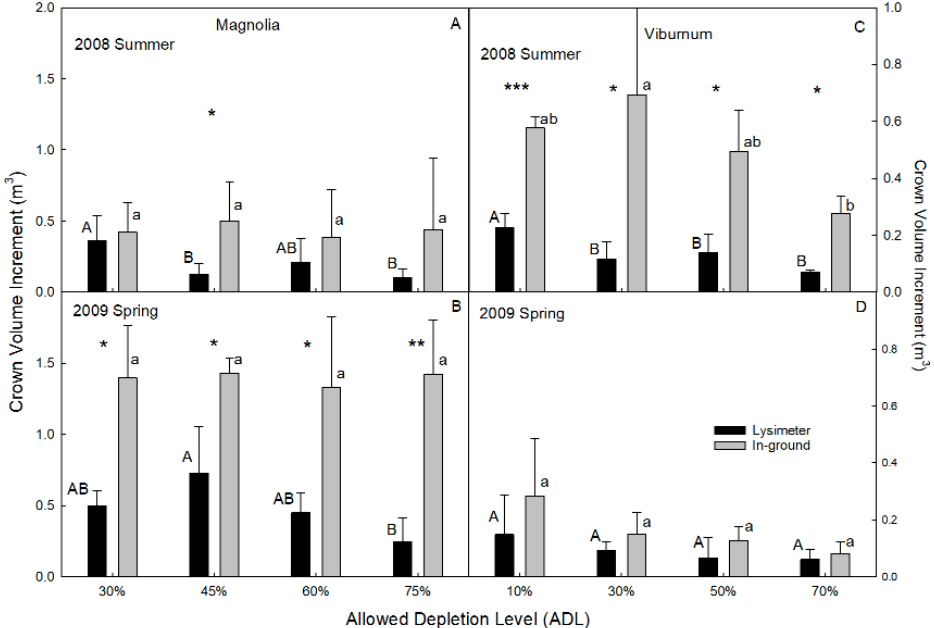
Figure 3. Effect of allowable depletion level (ADL) on crown volume (projected crown area x plant height) during the summer and spring study periods for southern magnolia ( Magnolia grandiflora, n = 4) and sweet viburnum ( Viburnum odoratissimum, n = 3) growing in lysimeter containers and subjected to four levels of allowable soil water depletion levels at the termination of the summer and spring studies. ( A , B ), Crown Volume Increment (CVI) in cubic meters of magnolia during the 2008 summer and 2009 spring; ( C , D ) CVI of viburnum during the 2008 summer and 2009 spring. Asterisks above the summer and spring experiment columns indicate significant seasonal differences at the 0.001 (***), 0.01 (**) and 0.05 (*) probability levels. Columns showing mean separation letters a, b or A, B are significantly different at p < 0.05 among the ADL treatments for the inground and lysimeter plants,